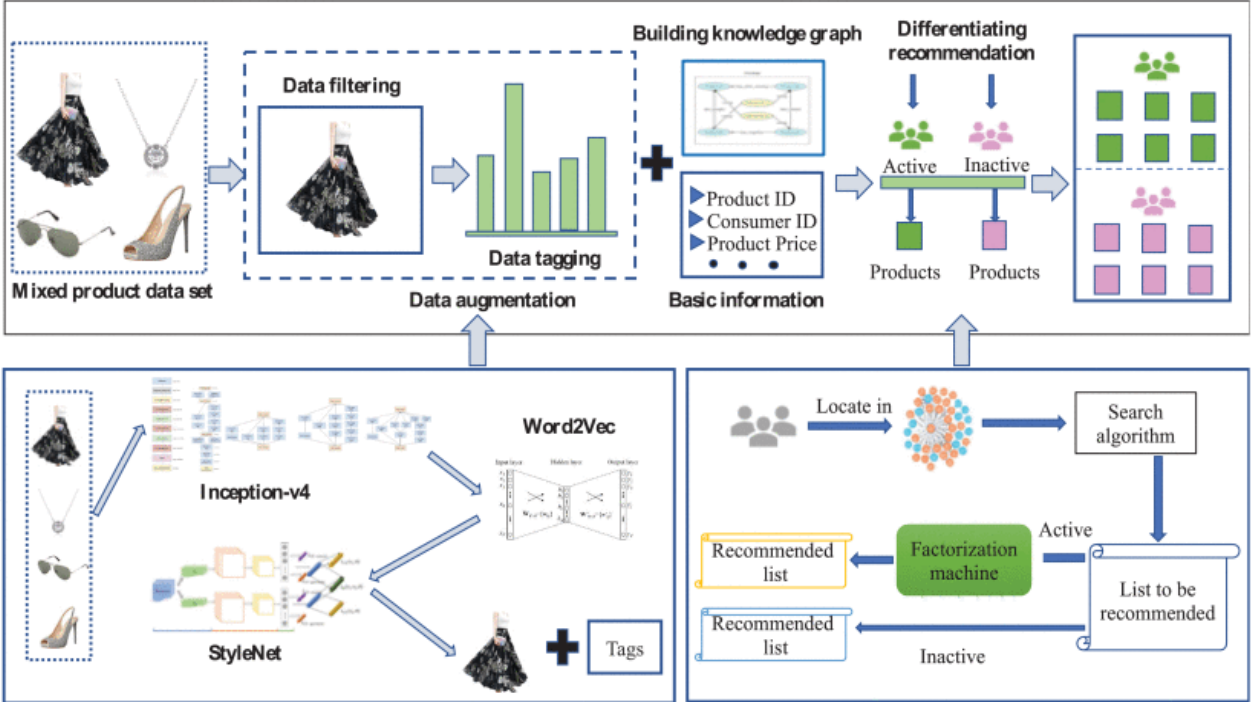
Figure 5. CNN-based approach using StyleNet Architecture.